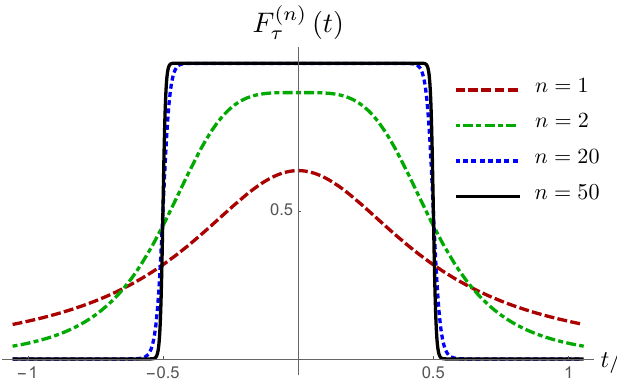
Figure 1 . Behavior of F ( n ) (cid:28) ( t ) given by eq. (4.4) for some representative values of n . The sudden switching regime is achieved when n ! 1